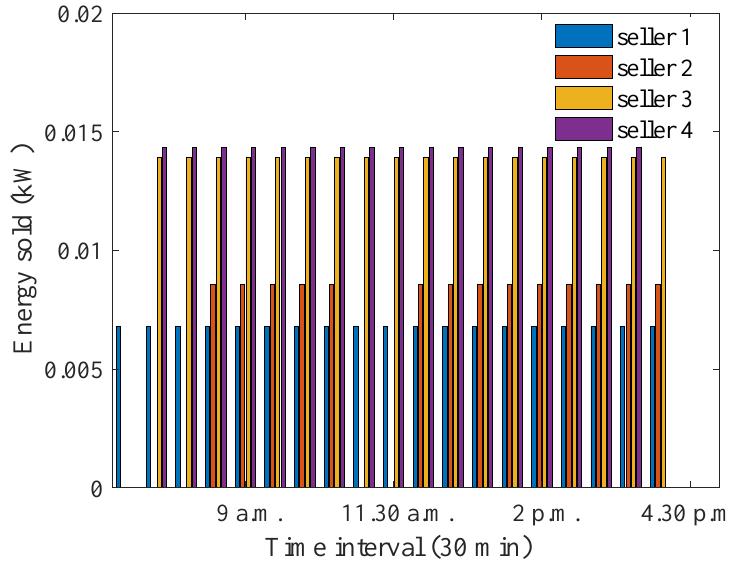
Figure 13. Optimum energy sold for equally preferred sellers and buyers during summer months.